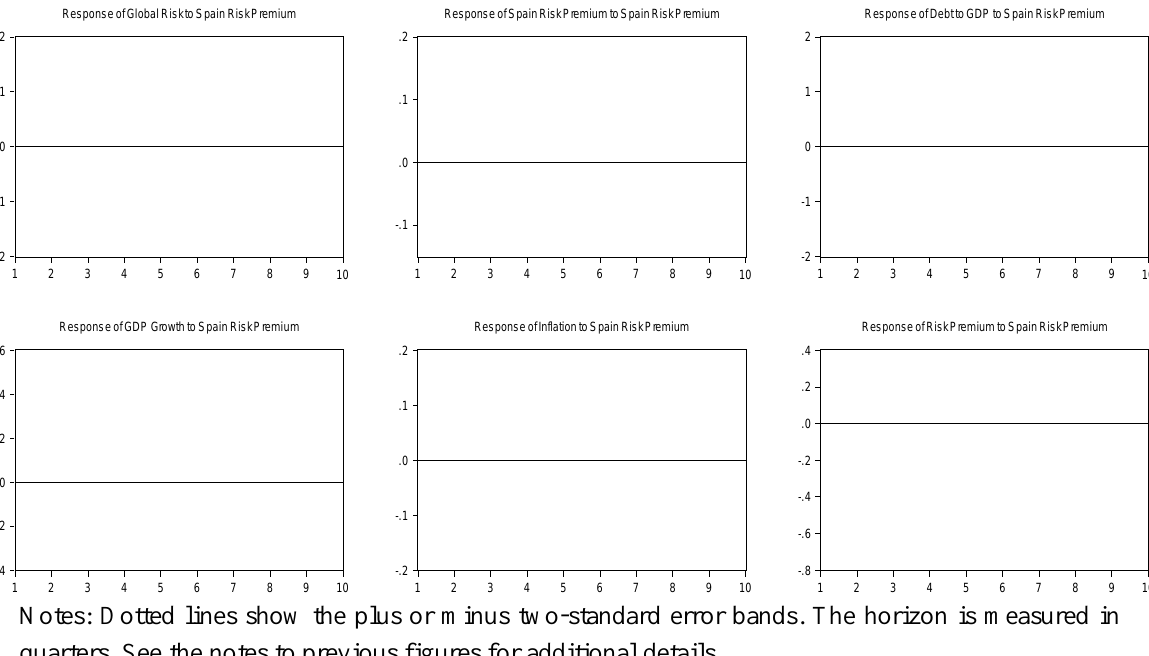
Figure 9. Response of EMU countries to a shock to Spain’s risk premium during the crisis: 2008–2011.